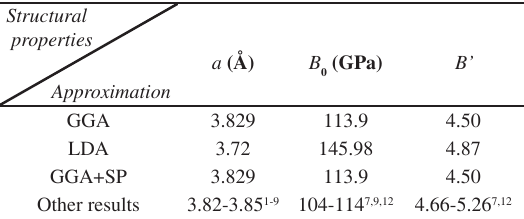
Table 1. The equilibrium lattice constant a (Å), bulk modulus B (GPa), pressure derivative of bulk modulus B’ calculated using GGA, LDA, GGA+SP approximation .